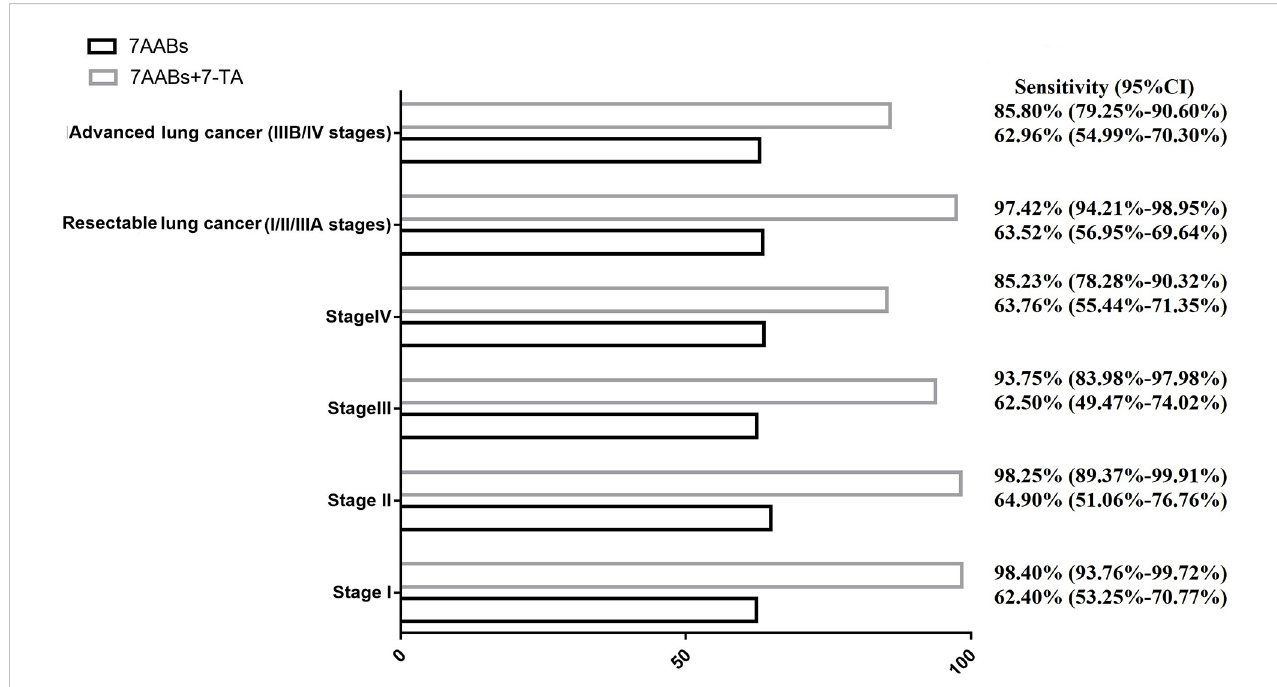
FIGURE 2 The combined sensitivity of 7-TAs and 7-AABs in diagnosis of lung cancer with different